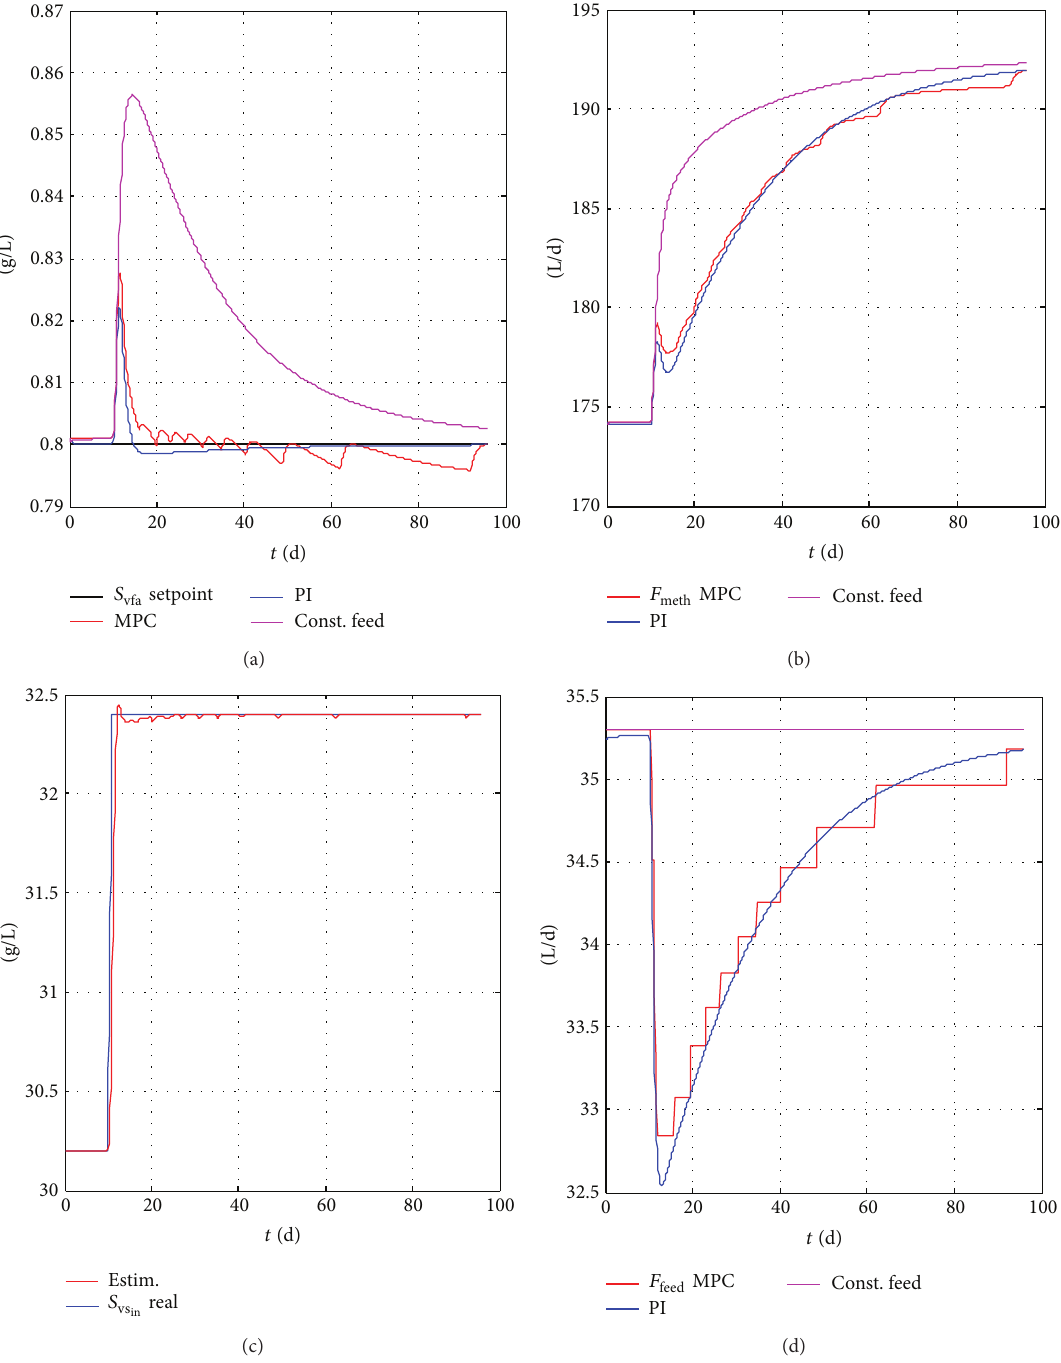
Figure 9: Control of 𝑆 with different control functions: constant 𝐹 vfa 𝑆 , 𝐹 , 𝐹 , and 𝑆 are vfa meth feed vs in